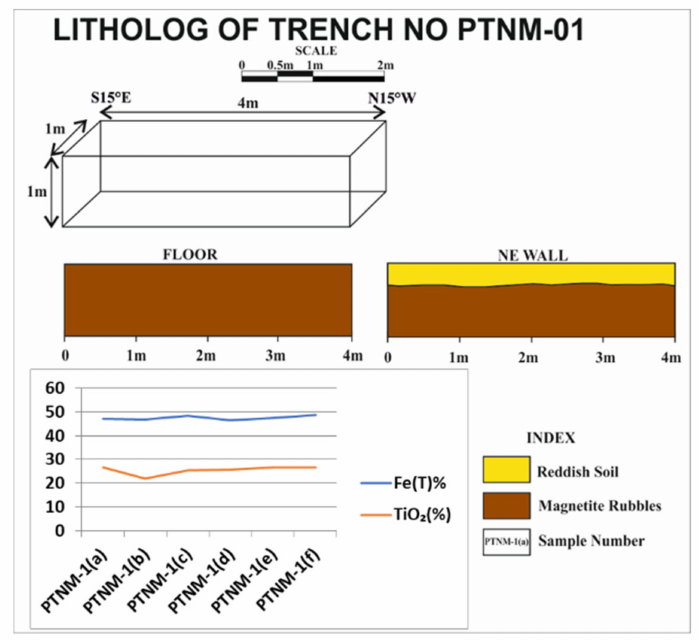
Figure 13. Litholog of trench PTNM-01 showing variation of Fe(T)% and TiO 2